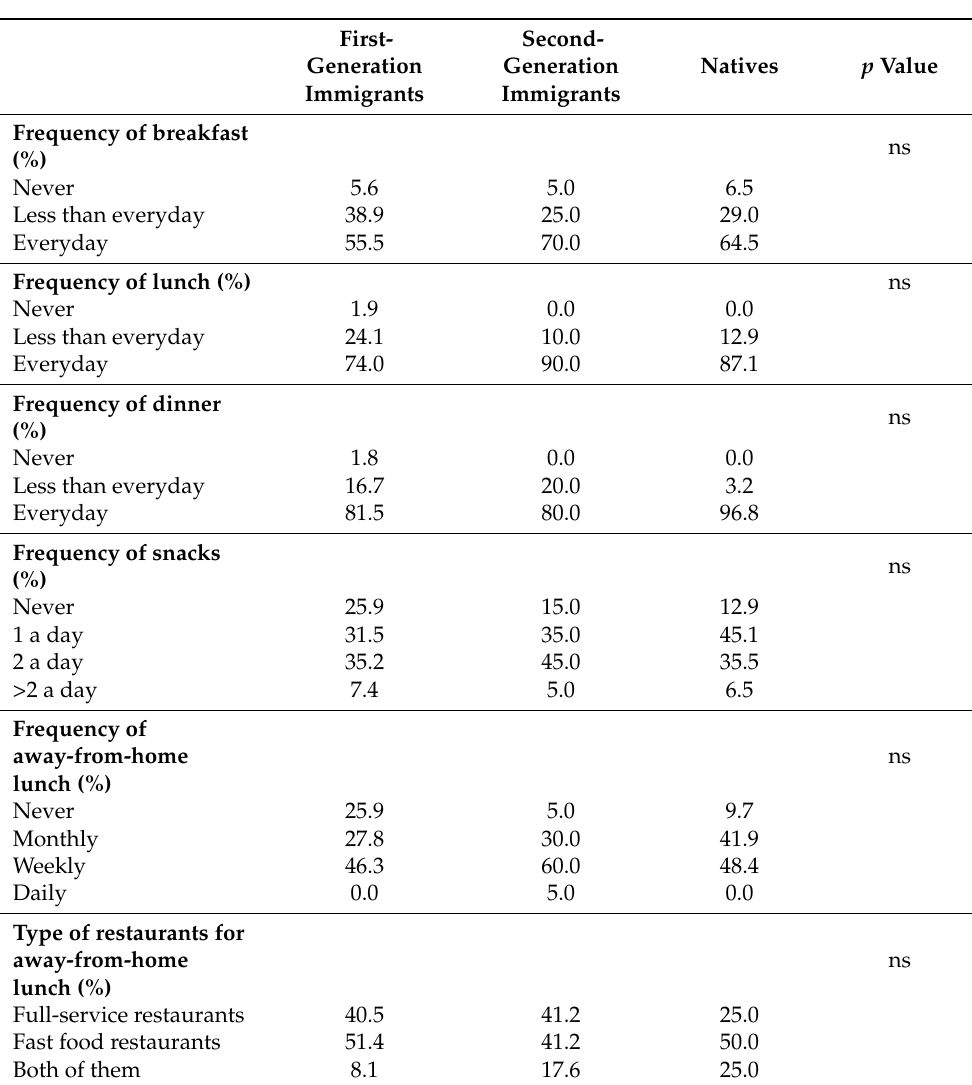
Table 6. Frequency of meal consumption, away-from-home meals, type of restaurant used, tendency to eat differently from family members or roommates by migration